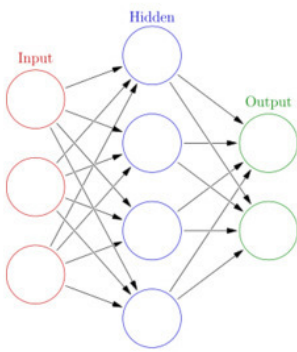
Figure 2. The structure of extreme learning machine (ELM). The parameters of the hidden layer are randomly generated, and the parameters of the output layer are adjusted by least squares